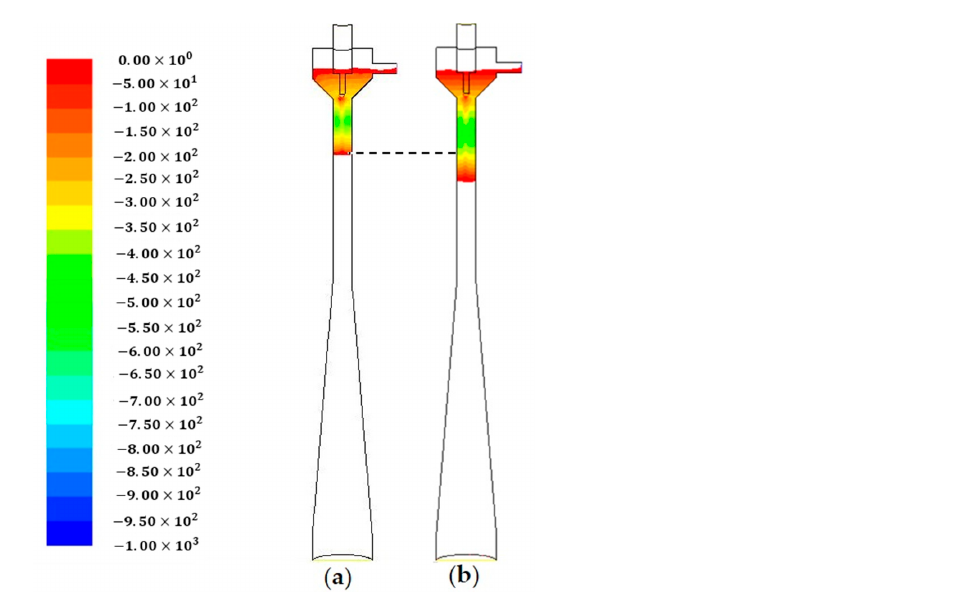
Figure 10. The effects of liquid flow rate on negative pressure, ( a ) flow rate: 2.49 × 10 − 4 m 3 /s, ( b ) flow rate: 2.64 × 10 − 4 m 3 /s.